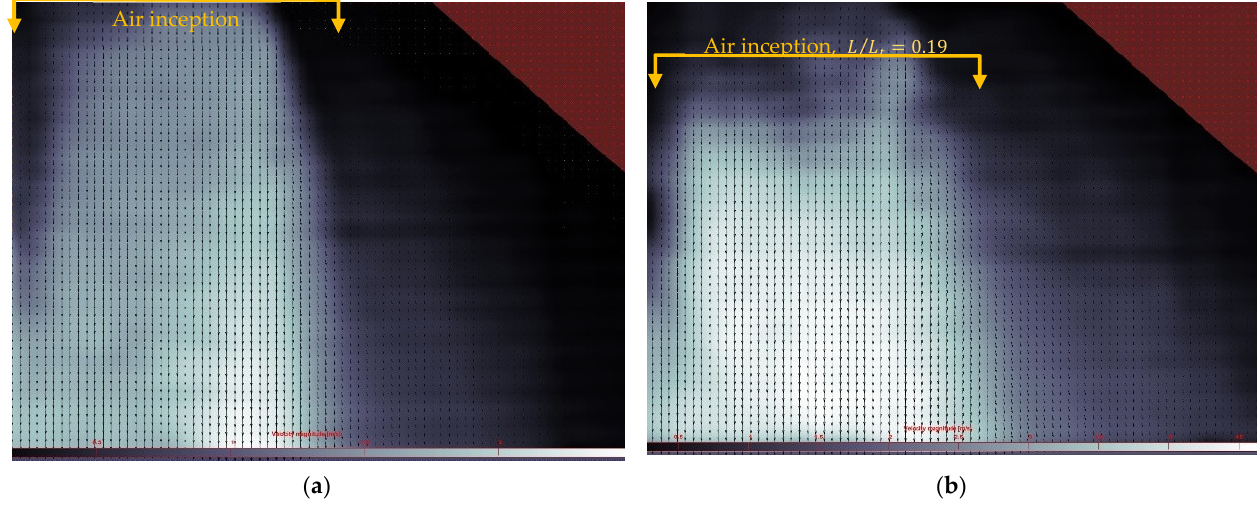
Figure 15. Velocity field obtained for 400 fps and ( a ) /ℎ = 1.13 and ( b ) /ℎ = 1.83 .